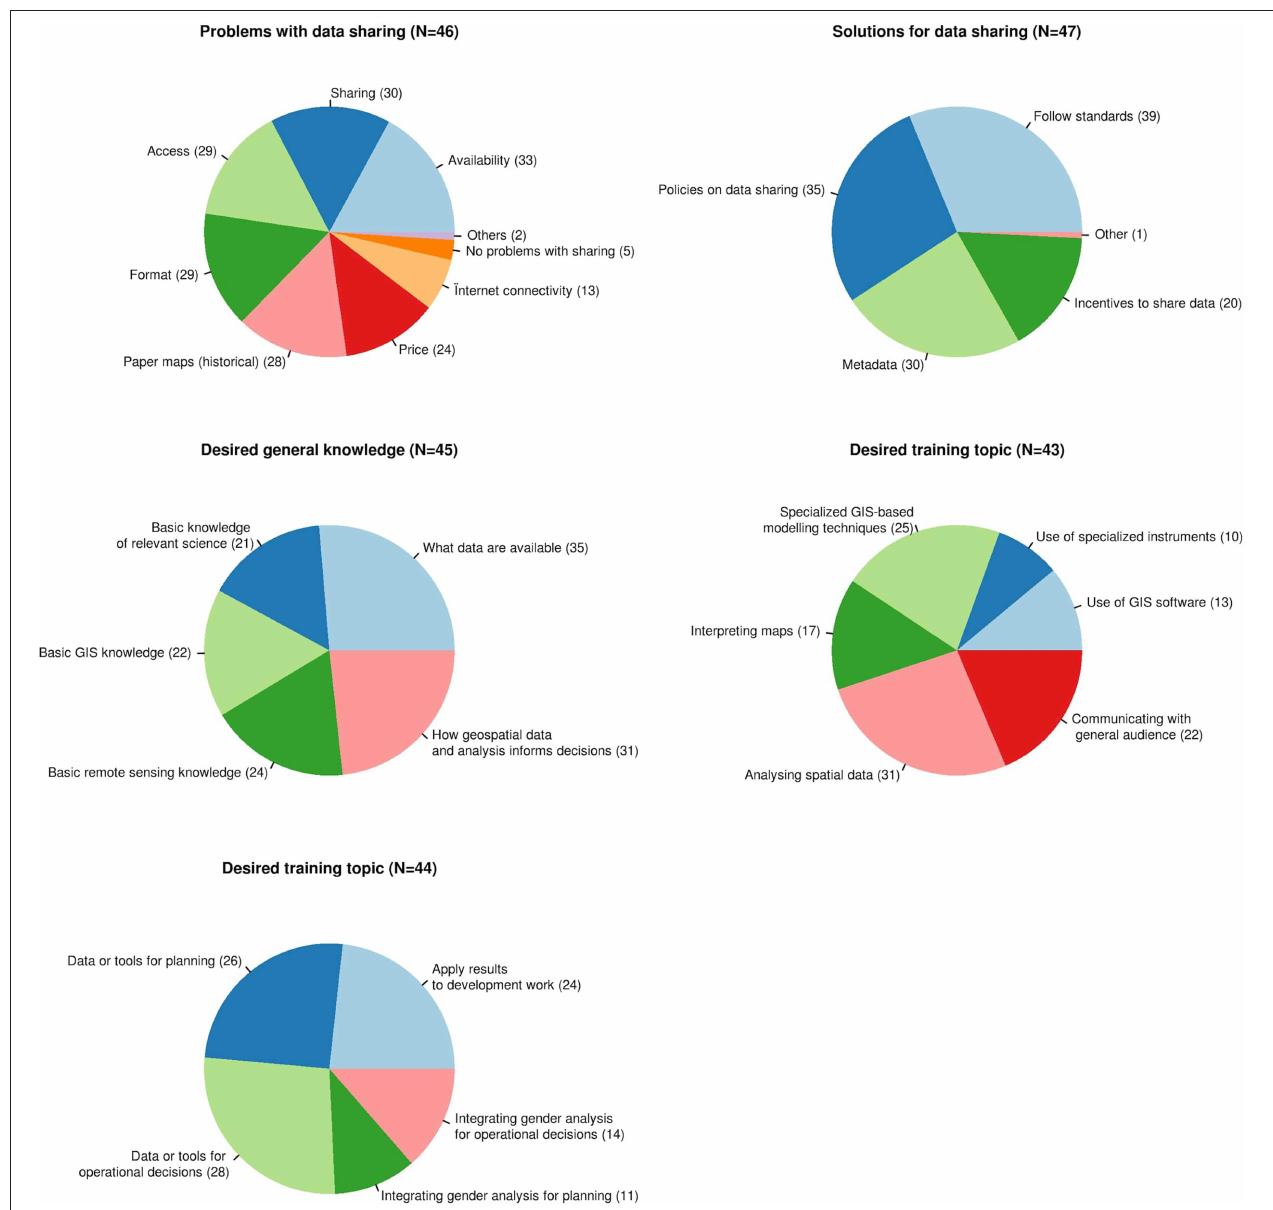
FIGURE 2 | Information on stakeholder responses and representation in the needs assessment process from the online questionnaire distributed in the Mekong region.